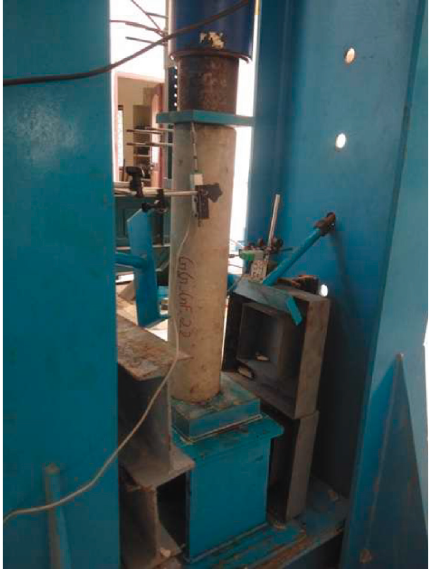
Figure 10: Test set up for axial